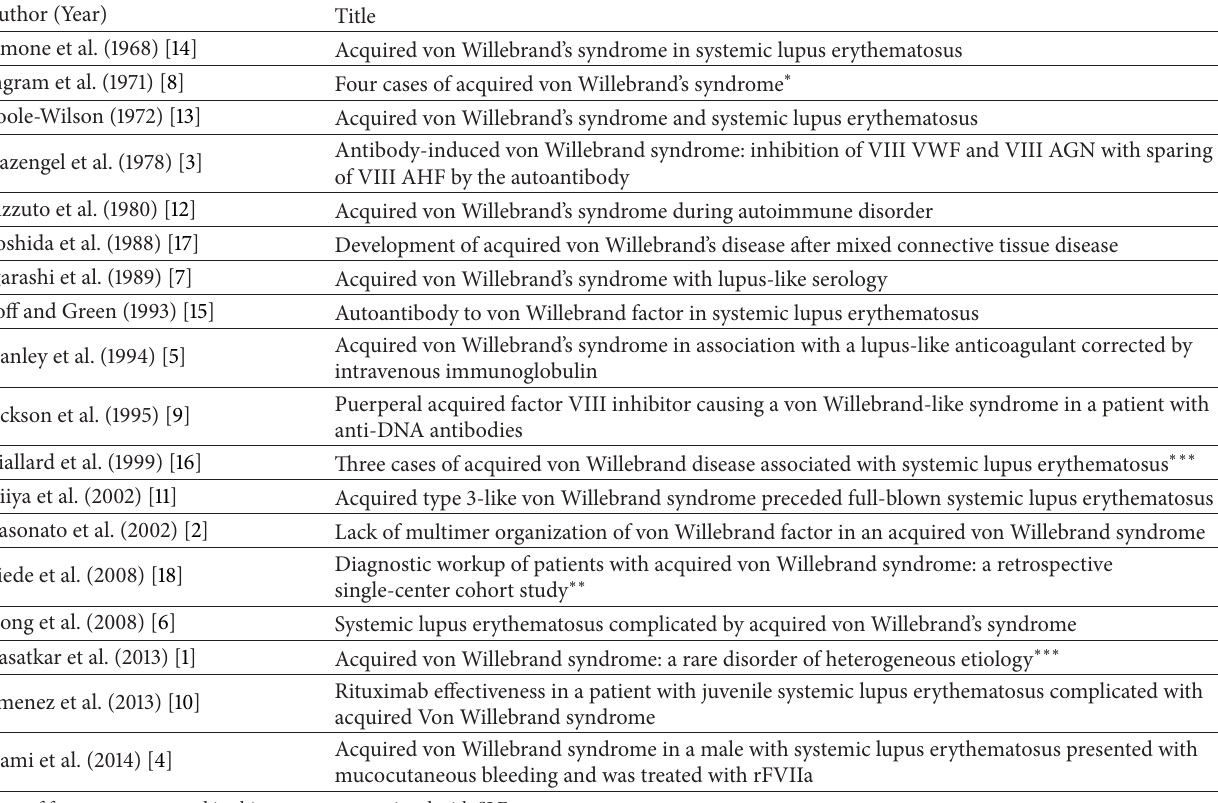
Table 2: AVWS in cases associated with SLE or lupus-like serology published to present